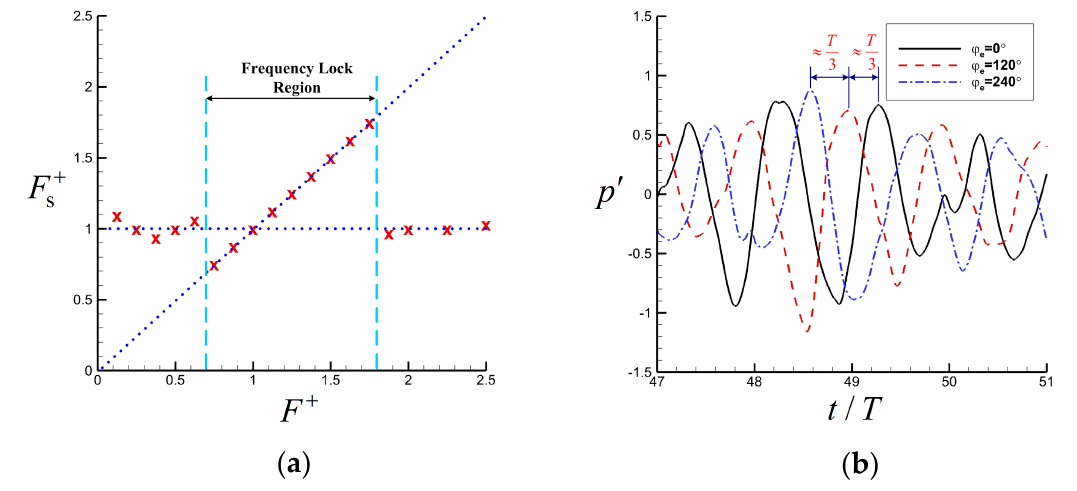
Figure 5. Lock-on effect in the curved diffuser with pulsed jet flow control: ( a ) Frequency locking (reduced dominant frequency of the system F + s versus reduced frequency of pulse jet F + ); ( b ) phase locking ( F + = 1 with different values of ϕ e ).